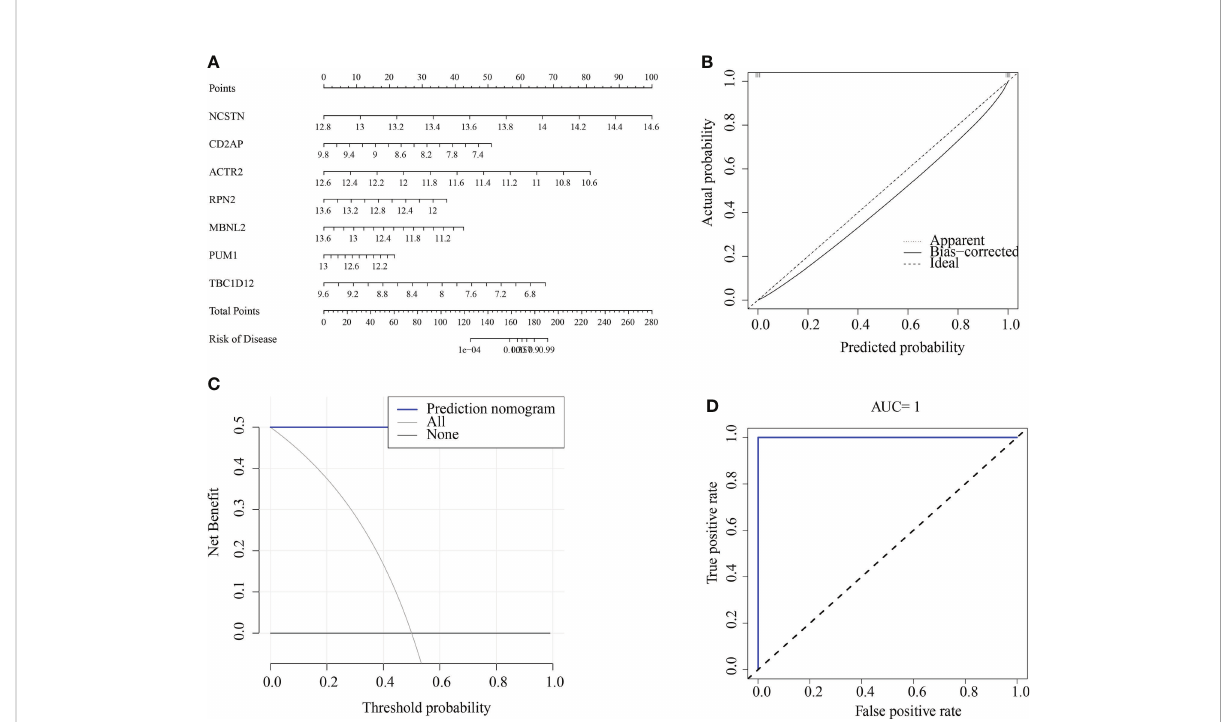
FIGURE 10 Construction and validation of a RM diagnostic column line graph model. (A) Column line graphs were used to predict the occurrence of RM. (B) Calibration curves assessed the predictive power of the column line graph model. (C) DCA curves were used to assess the clinical value of the column line graph model. (D) ROC curves assessed the clinical value of the column line graph